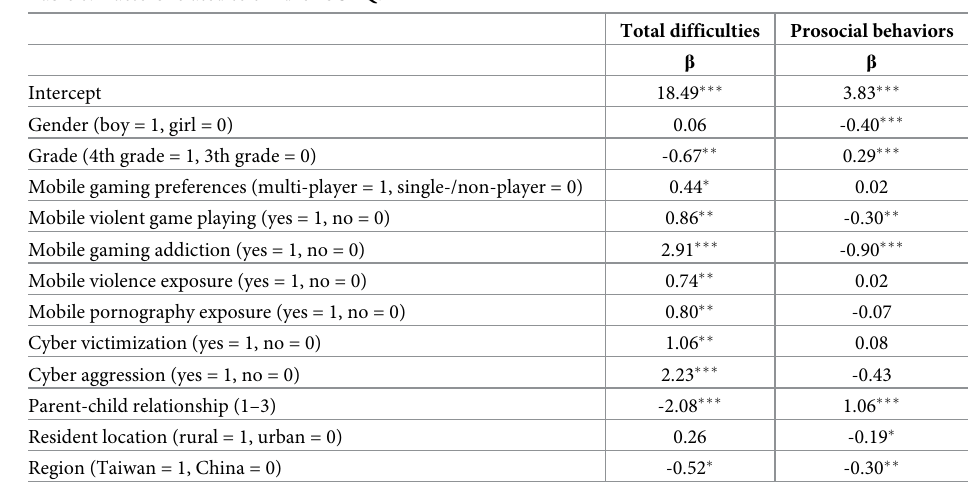
Table 6. Factors related to children’s